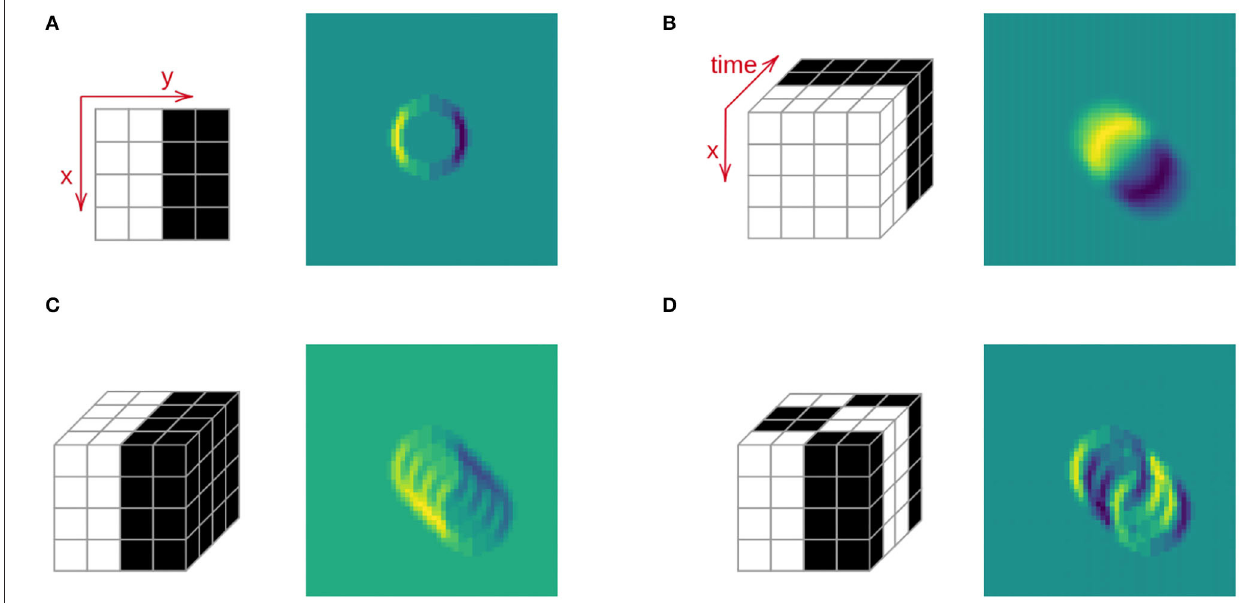
FIGURE 3 | Filtering with 2D vs. 3D kernels. The target is moving in the direction north-west. The range of values goes from 0 (purple) to 1 (yellow). (A) 2D filtering (on a single frame). (B) 3D temporal filtering. (C) 3D spatial filtering. (D) 3D spatio-temporal